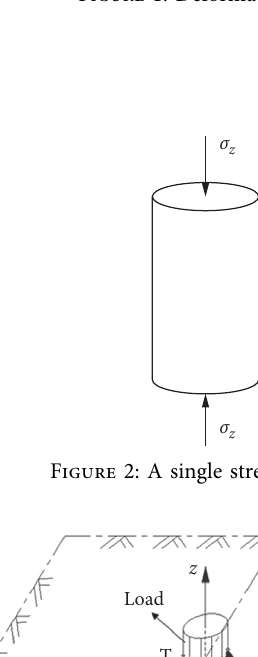
Figure 1: Deformation curves: (a) common material; (b) ideal elastoplasticity; (c) rigid plasticity.